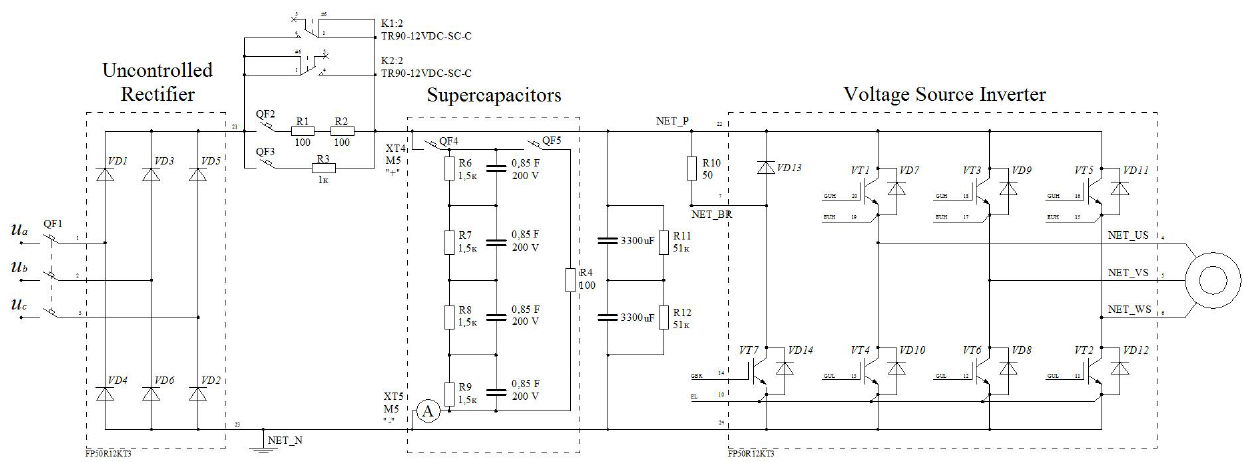
Figure 1. Functional diagram of frequency converter with supercapacitors